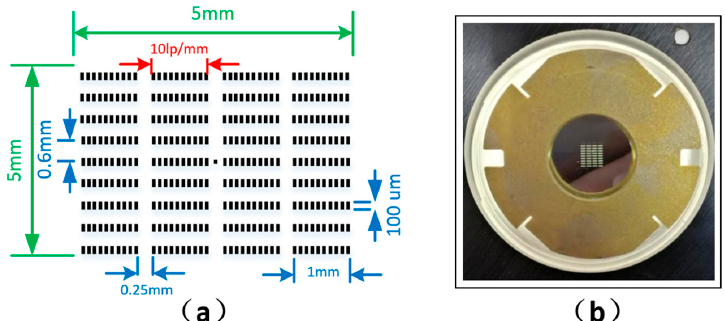
Figure 3. Picture of the pattern and the photocathode: ( a ) metal chromium reticle pattern; ( b ) photocathode assembly.